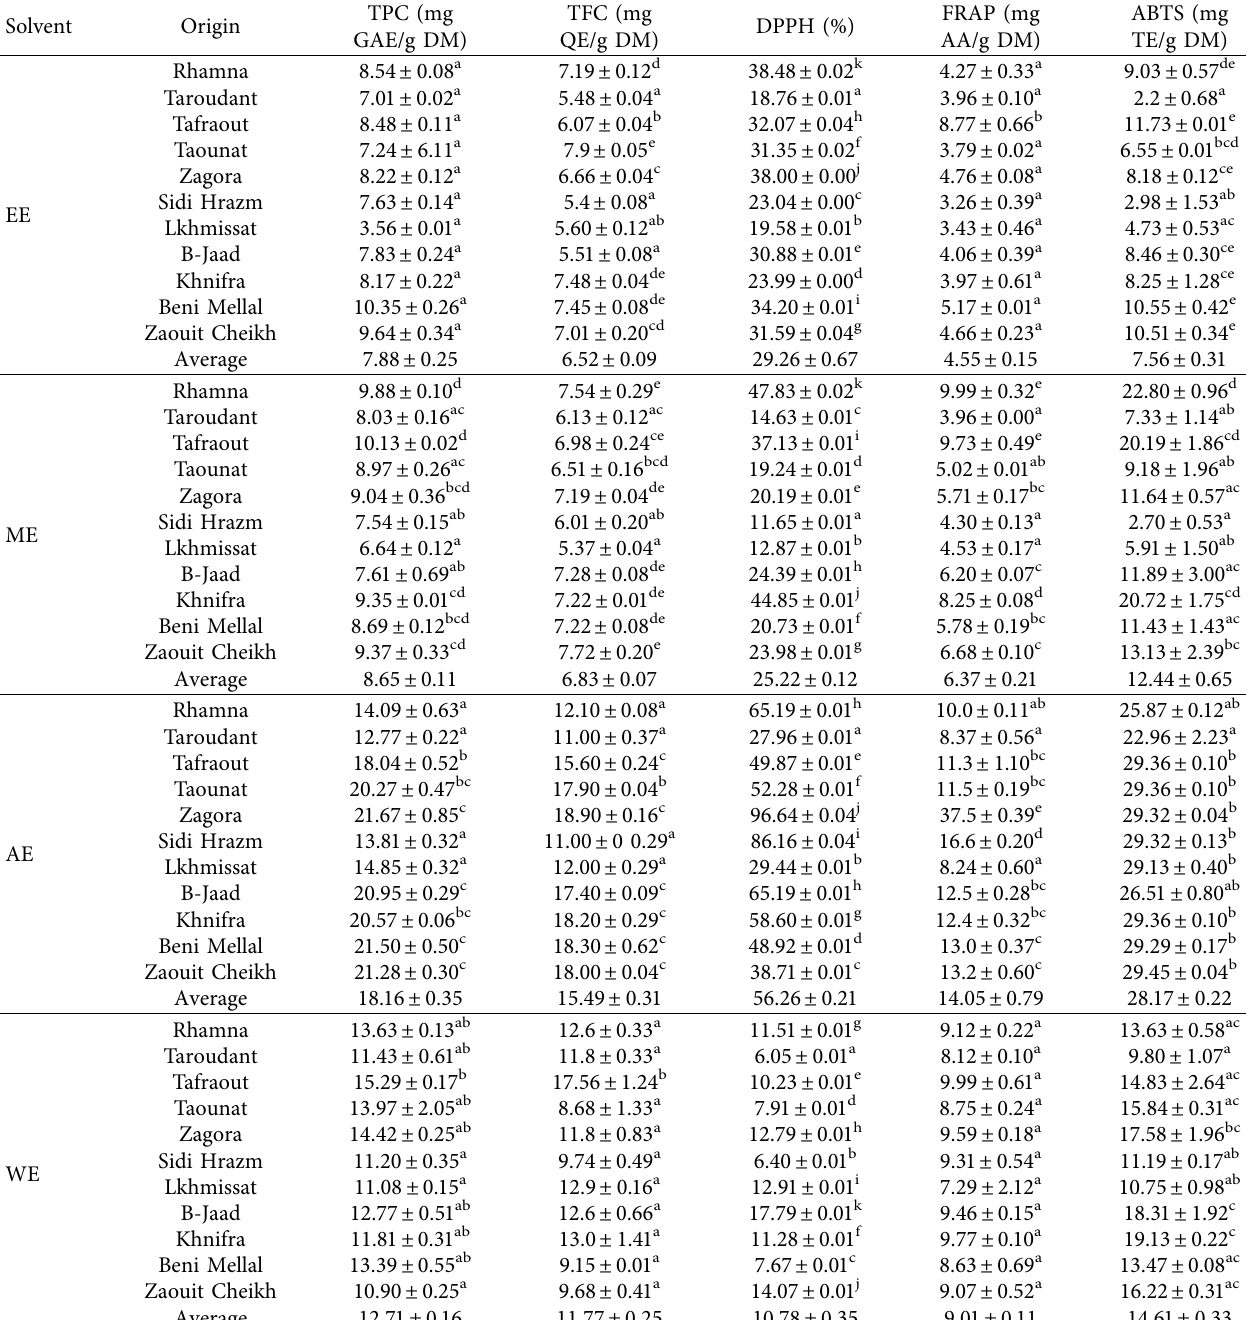
Table 5: Mean values ± standard deviation of total phenolic contents, favonoid contents, and antioxidant activities of diferent extracts of Z . lotus (AE: acetone extract, EE: ethanolic extract, ME: methanolic extract, and WE: water extract).